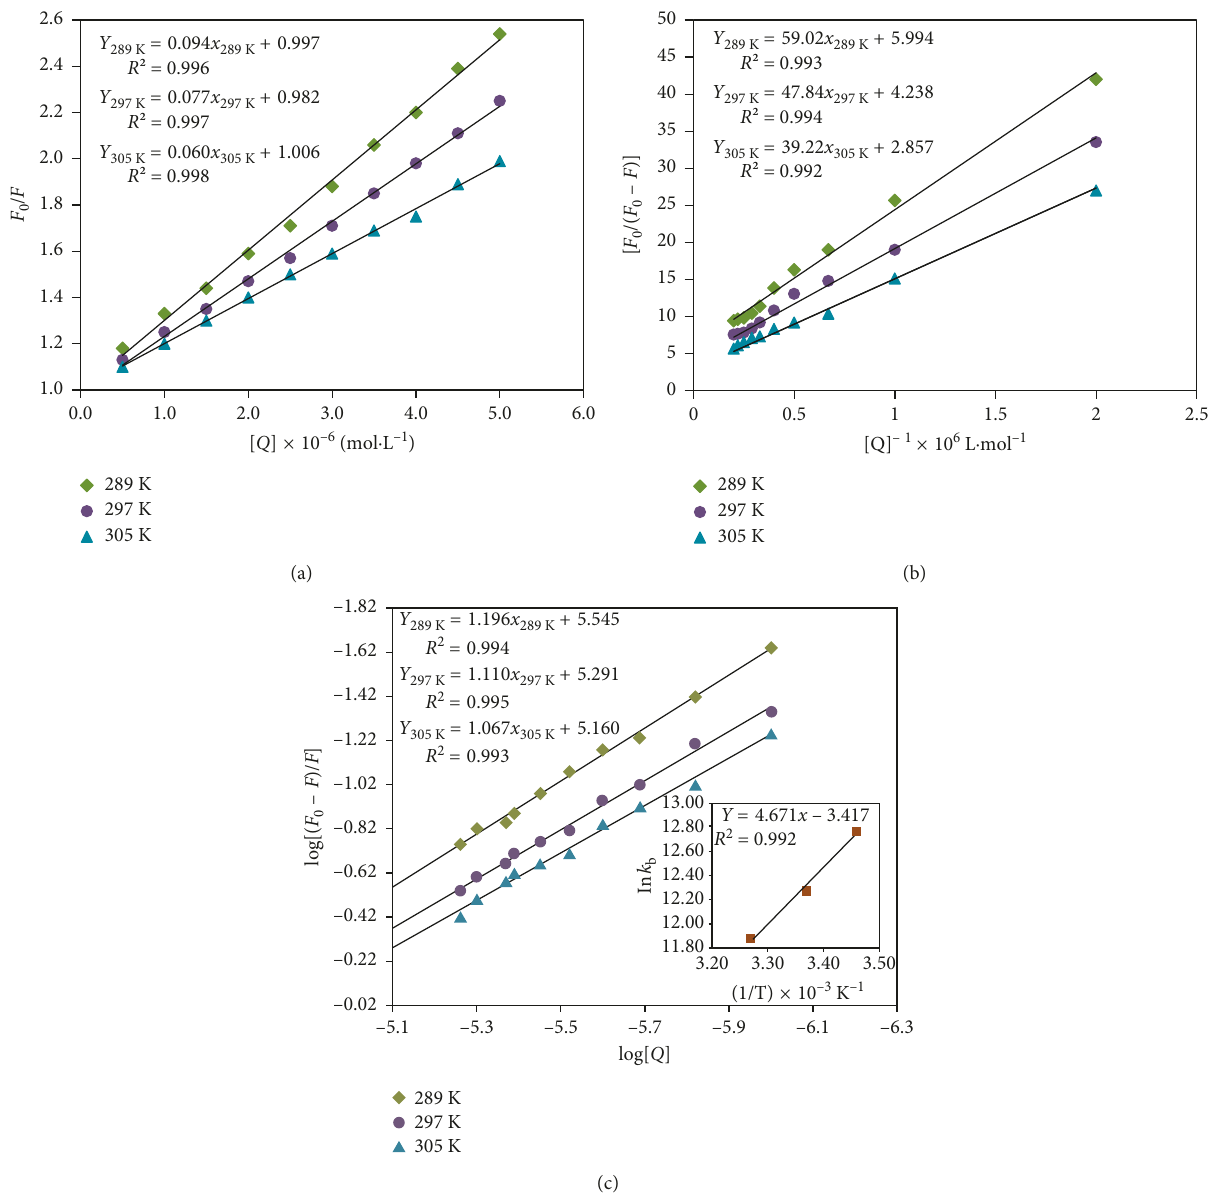
Figure 4: (a) Stern–Volmer plot, (b) modified Stern–Volmer plot, and (c) plot of log [( F plot of the BSA-RSN complex) at different temperatures (289, 297, and 305K) at pH 7.40. Table 1: Stern–Volmer quenching constant, quenching rate constant, and effective static quenching constant for the BSA-RSN complex at different temperatures at pH 7.40.